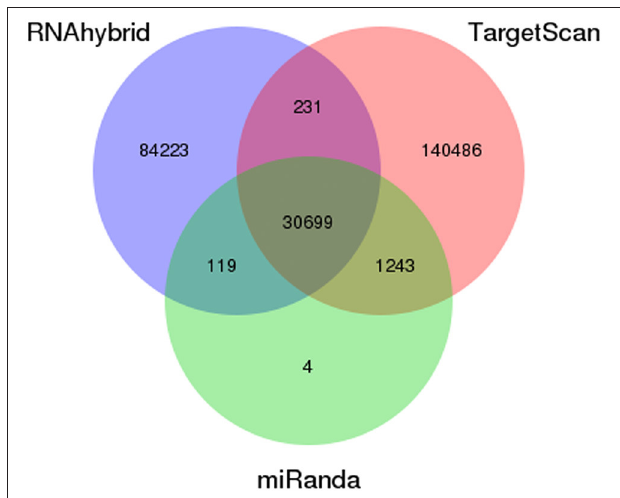
FIGURE 4 | Prediction of potential target genes in all libraries. Venn diagram show the number of miRNA targets and their overlapping spots predicted by the three programs (RNAhybrid, miRanda, and